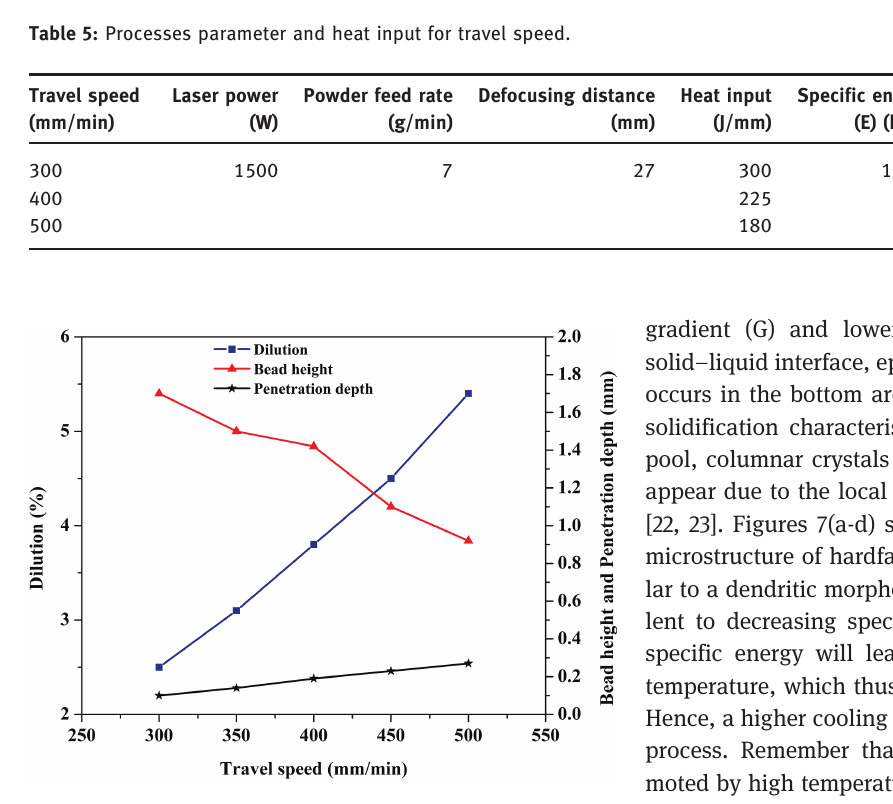
Figure 5: Effects of travel speed on bead height, penetration depth and